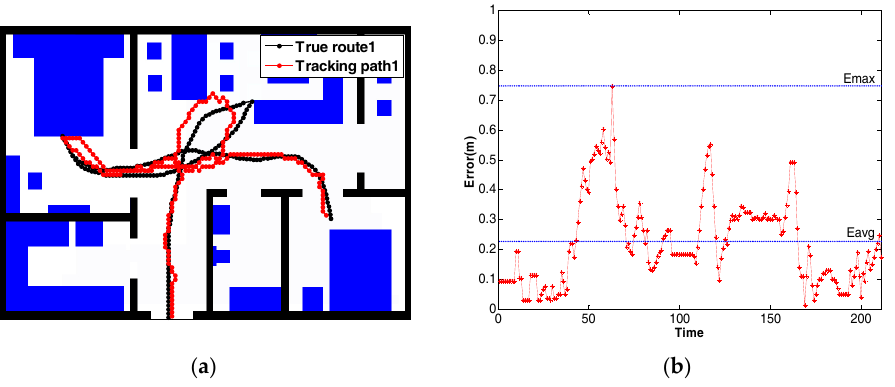
Figure 12. The result of position tracking with True route1 . ( a ) The path estimated with True route1 ; ( b ) The error curve for True route1 .